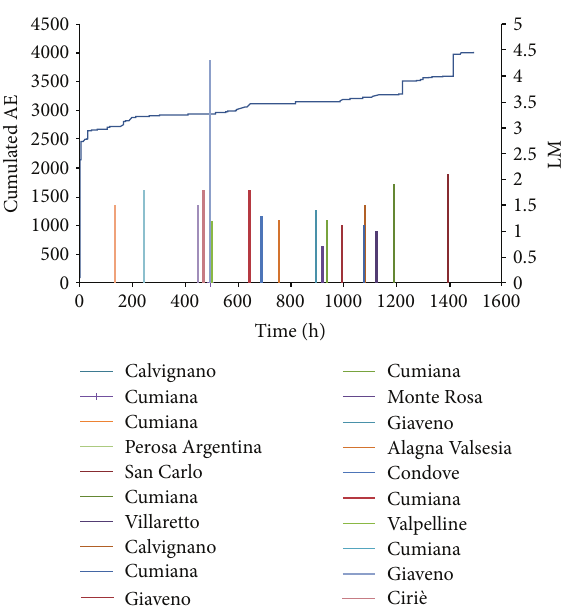
Figure 10: Sacred Mountain of Varallo: cumulated AE and seismic events from July 5, 2011 to September 5, 2011 (LM: local magnitude).